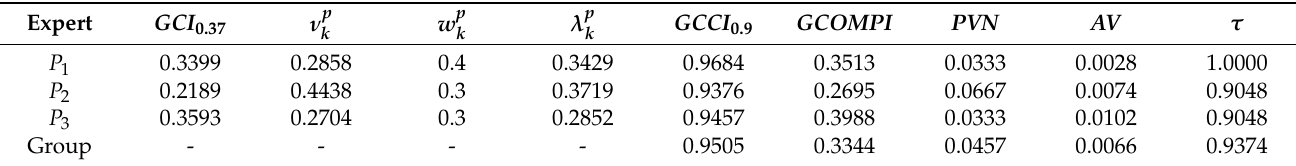
Table 11. Group consensus in Node